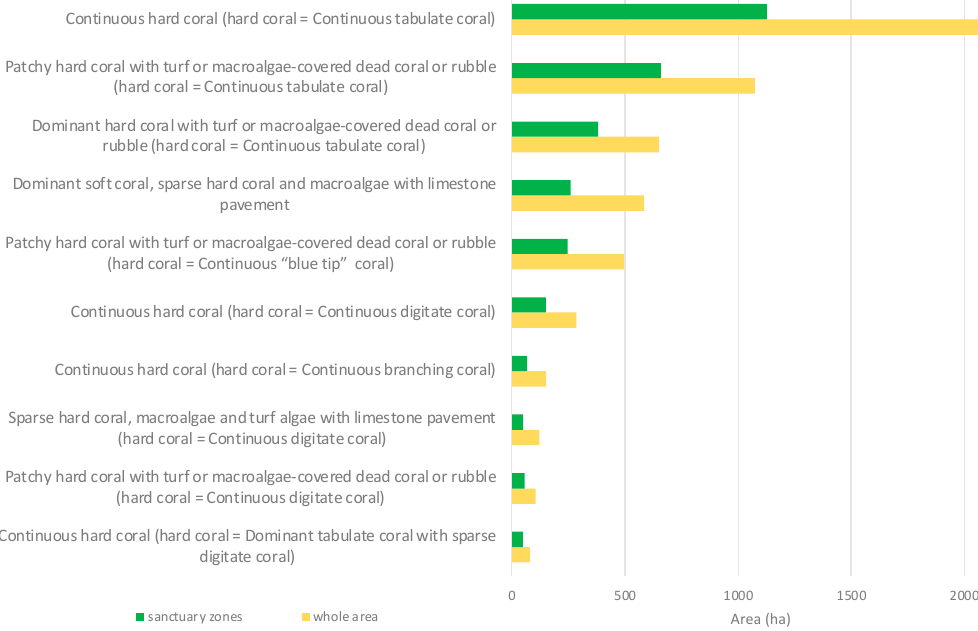
Figure 3. Summary of coral mosaics within the Ningaloo Reef study area (<20 m depth) and in sanctuary zones. Data are sorted by the area covered from largest to smallest for the top 10 classes, accounting for 97% of the total coral cover.